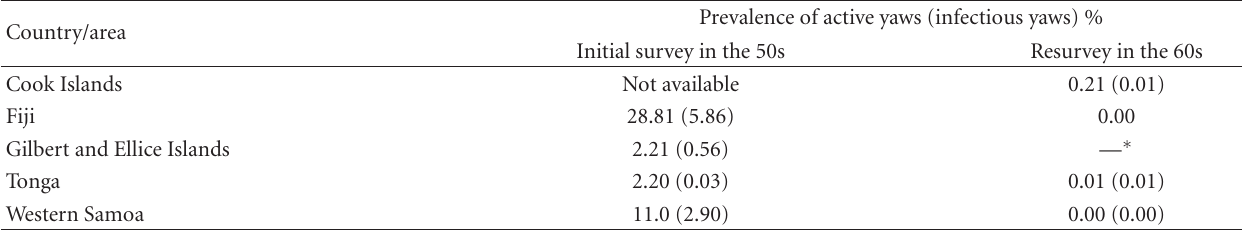
Table 6: Prevalence of yaws pre- and postmass treatment in the 1950s and 1960s in Pacific countries [26].